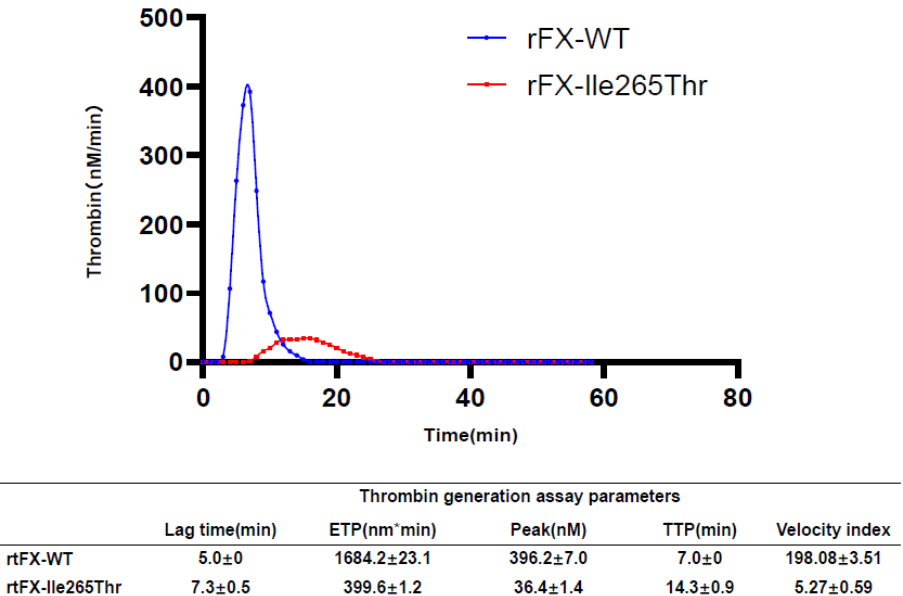
Figure 6. The procoagulant potential of recombinant FX variant. Thrombin generation assays of FX-WT(blue) and FX- Ile265Thr (red) in commercially available FX-deficient plasma using TECHNOTHROMBIN ® TGA RC Low kit was meas- ured for 60 min in 1 min intervals at 37 °C . Above is the graph of thrombin generation and below are the parameters of this assay. Data are derived from three independent measurements (SD). For the splicing mutation IVS7 + 5G > A in F10, the minigene pcMINI-FX-WT/Mut was constructed. The pcMINI-FX-WT/Mut is with intro6(363 bp)-Exon7(118 bp)-in- tro7(479 bp) inserted into pcMINI vector. Sequencing of the minigenes is showed in Figure 7A. The RT-PCR results showed that in 293T and MCF-7 cells, the wild type had a band of the expected sizes (band a, 507 bp, Figure 7B), and the mutant type had a band of the same size. All the bands were sent for sequencing. Expected splicing mode is shown in Figure 7C. Sequencing results show that band a was a normal splicing band, and its splic- ing mode is ExonA-Exon7(118 bp)-ExonB. (Figure 7D). According to the minigene assay, the splicing mutation does not affect the normal splicing.